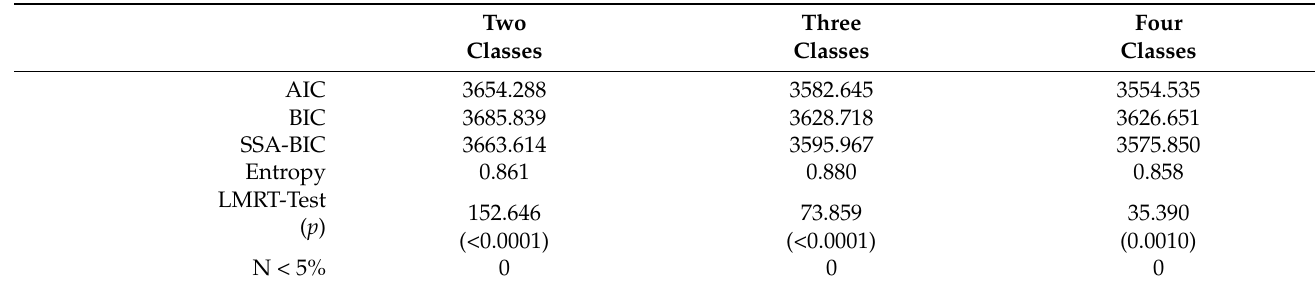
Table 2. Statistics of two, three, and four latent model fitting.